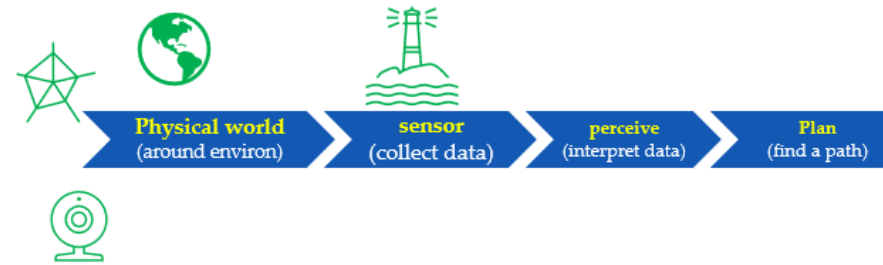
Figure 13. Finding a path and planning to determine the next action.